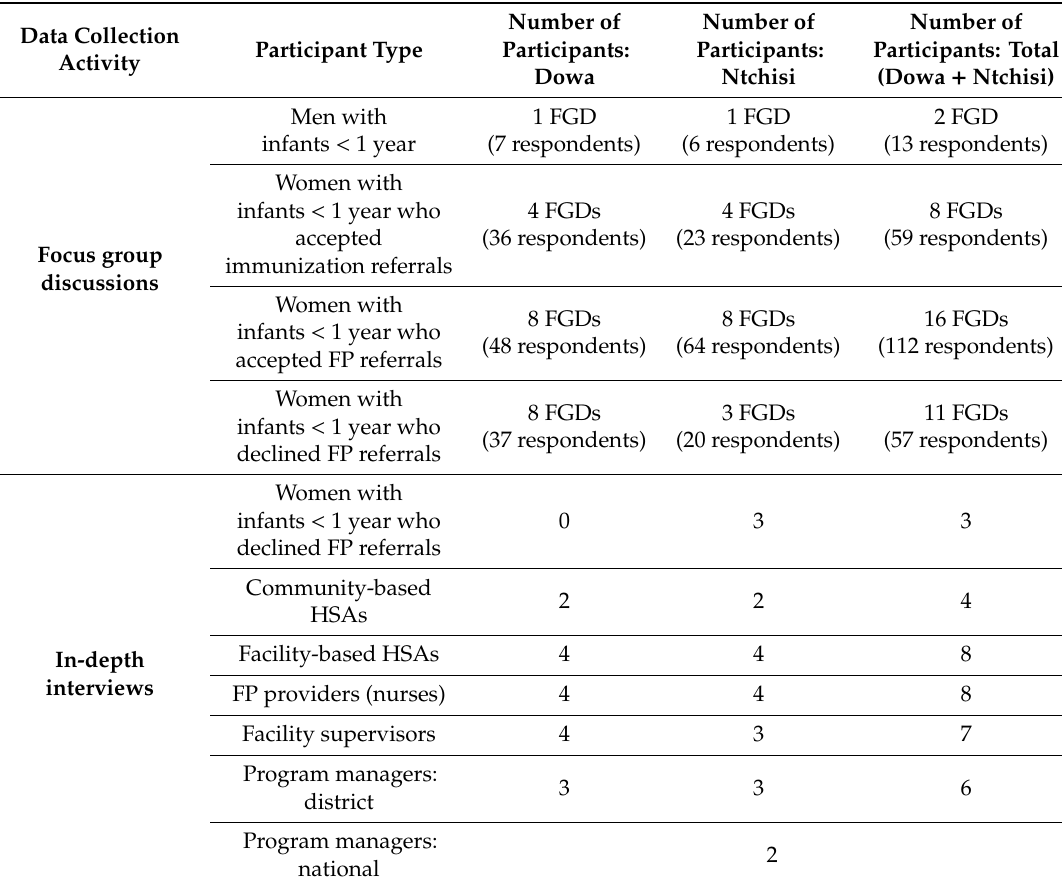
Table 1. Respondent